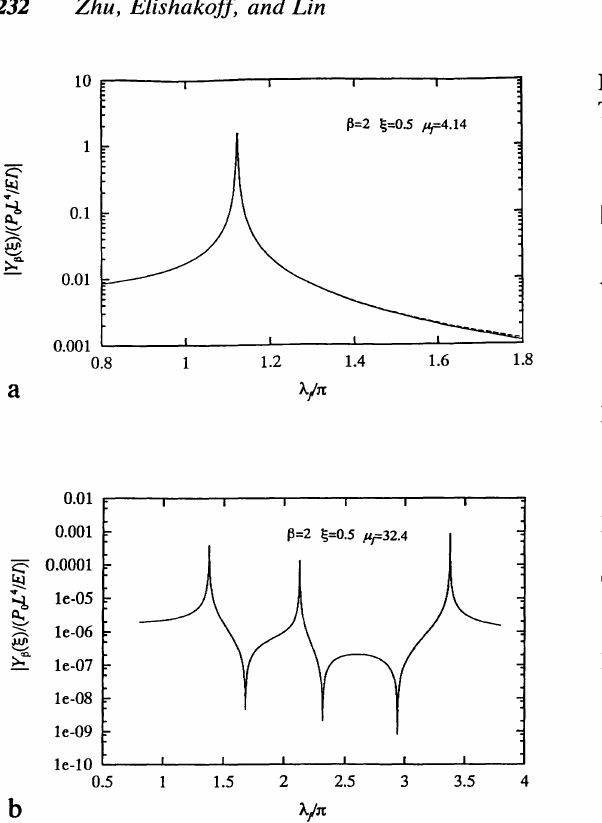
FIGURE 6(a) Nondimensional harmonic response of an infinitely long multi-span beam in the first band (- by present approach; --- by Mead's approach) FIGURE 6(b) Nondimensional harmonic response of an infinitely long multi-span beam in the first three bands (- by present approach; --- by Mead's ap